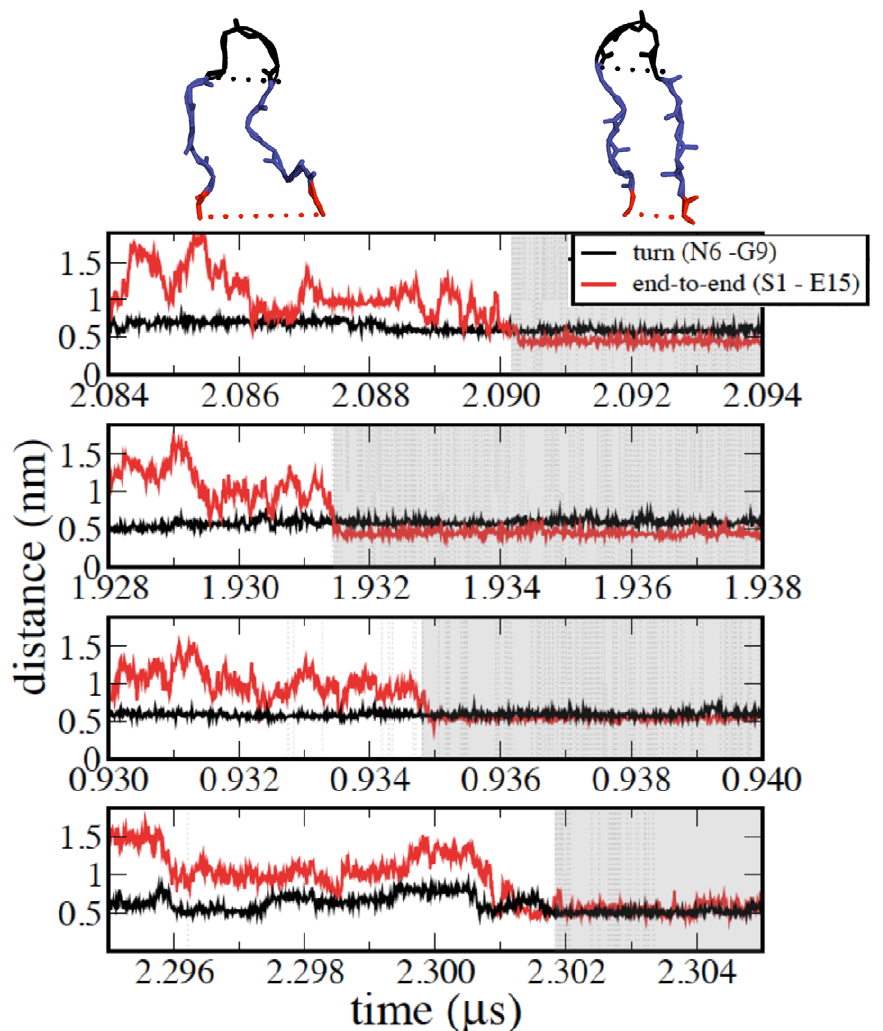
Figure 7. Representative forward reactive paths illustrating the events occurring prior to reaching the TS. The TS region is shaded in grey. The time evolution of the distance between the C a atoms of the turn (N6-G9) and end (S1-E15) residues are plotted in black and red, respectively.